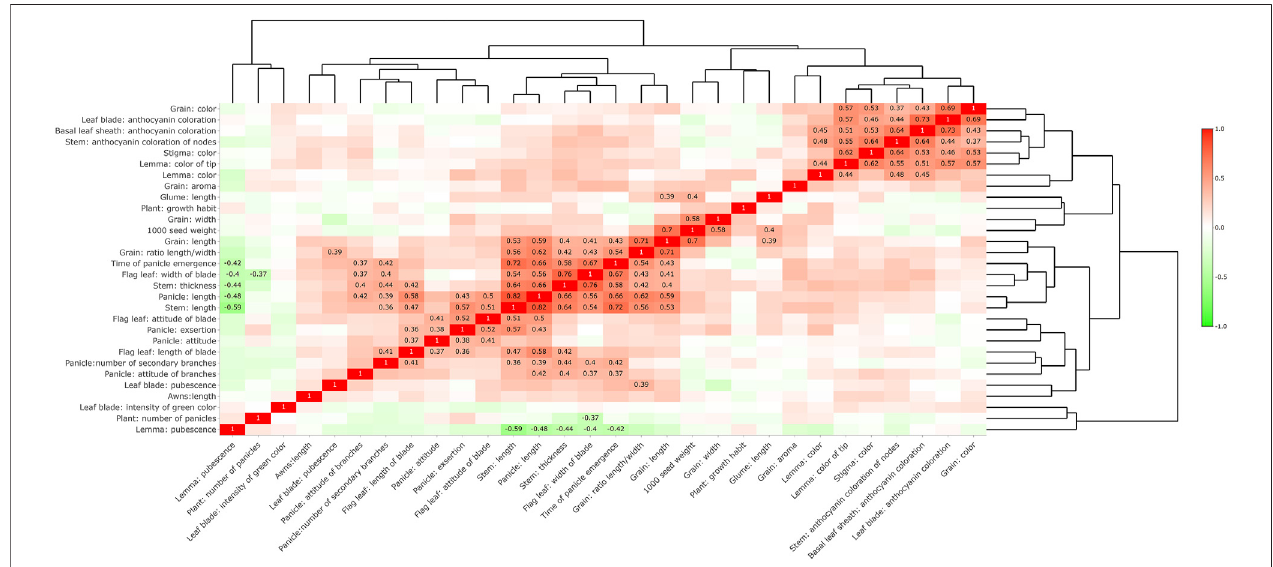
TABLE 4 | Correlation between predicted and true values of traits achieved by using rrBLUP. No. Trait Correlation (predicted vs. Group No. Trait Correlation (predicted vs. Group measured traits) measured traits) 1 Basal leaf sheath: anthocyanin coloration 0.129 A 16 Panicle: exsertion 0.608 B 2 Plant: growth habit 0.760 B 17 Glume: length 0.186 A 3 Leaf blade: intensity of green color 0.102 A 18 Lemma: color 0.540 B 4 Leaf blade: anthocyanin coloration 0.232 Grain: ratio length/width 0.565 B 5 Leaf blade: pubescence 0.447 B Grain: color 0.360 Time of panicle emergence 0.765 Grain: aroma 0.287 Awn: length 0.307 Plant: number of panicles Lemma: color of tip 0.384 Stem: thickness Stigma: color 0.307 Stem: length 0.840 Stem: anthocyanin coloration of nodes 0.354 Flag leaf: length of blade 0.378 Lemma: pubescence 0.648 Flag leaf: attitude of blade 0.563 Panicle: length 0.760 Panicle: attitude 0.614 Panicle: number of secondary branches 0.441 Panicle: attitude of branches 0.439 Grain: width